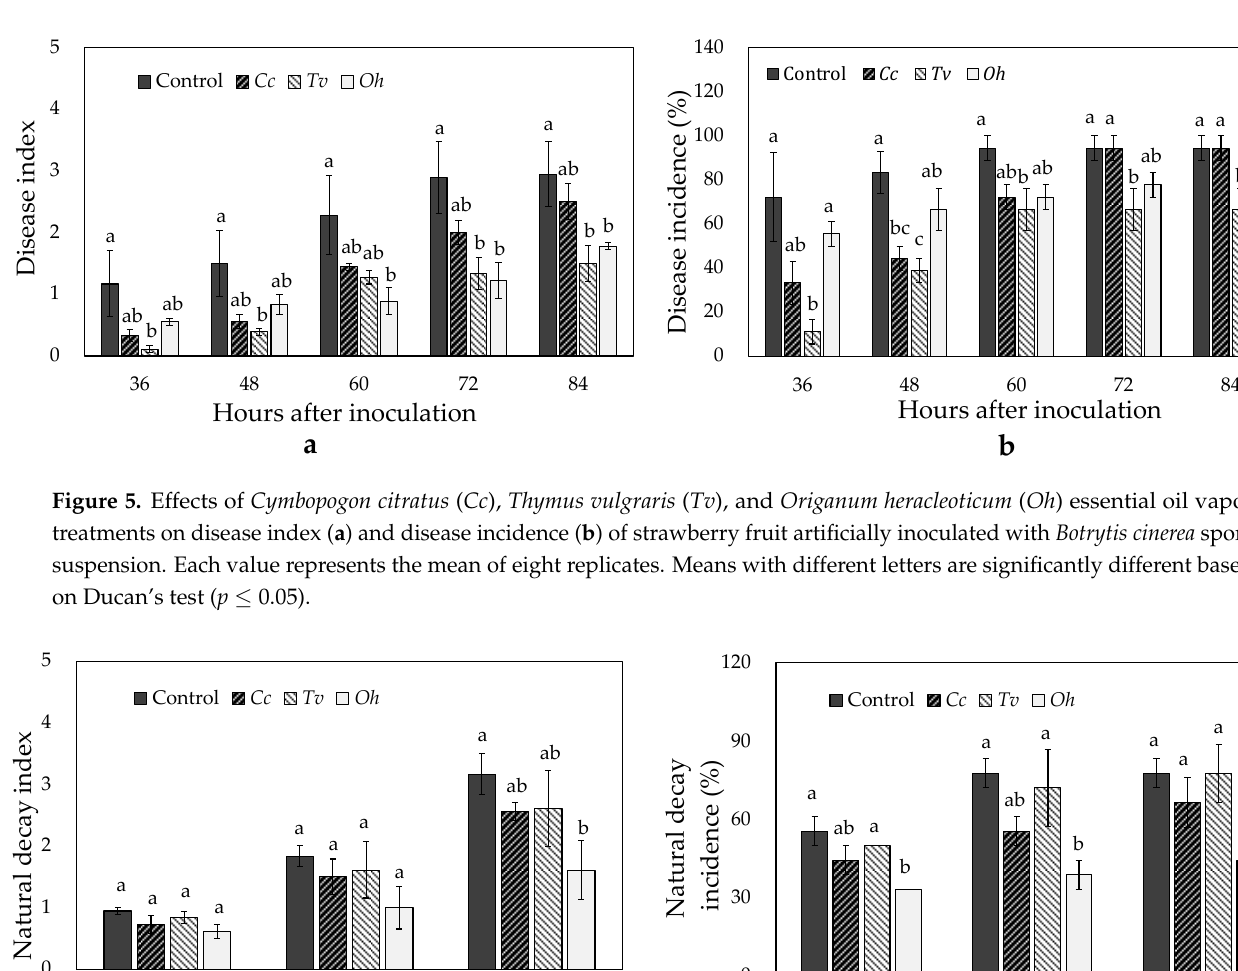
Figure 4. Effects of essential oils from Cymbopogon citratus ( Cc ), Thymus vulgraris ( Tv ), and Origanum heracleoticum ( Oh ) essential oil on leakage of nucleic acids ( a ), proteins ( b ), and soluble sugars ( c ) of Botrytis cinerea mycelium. Each value represents the mean of ten replicates. Means with different letters are significantly different based on Ducan’s test ( p ≤ 0.05).